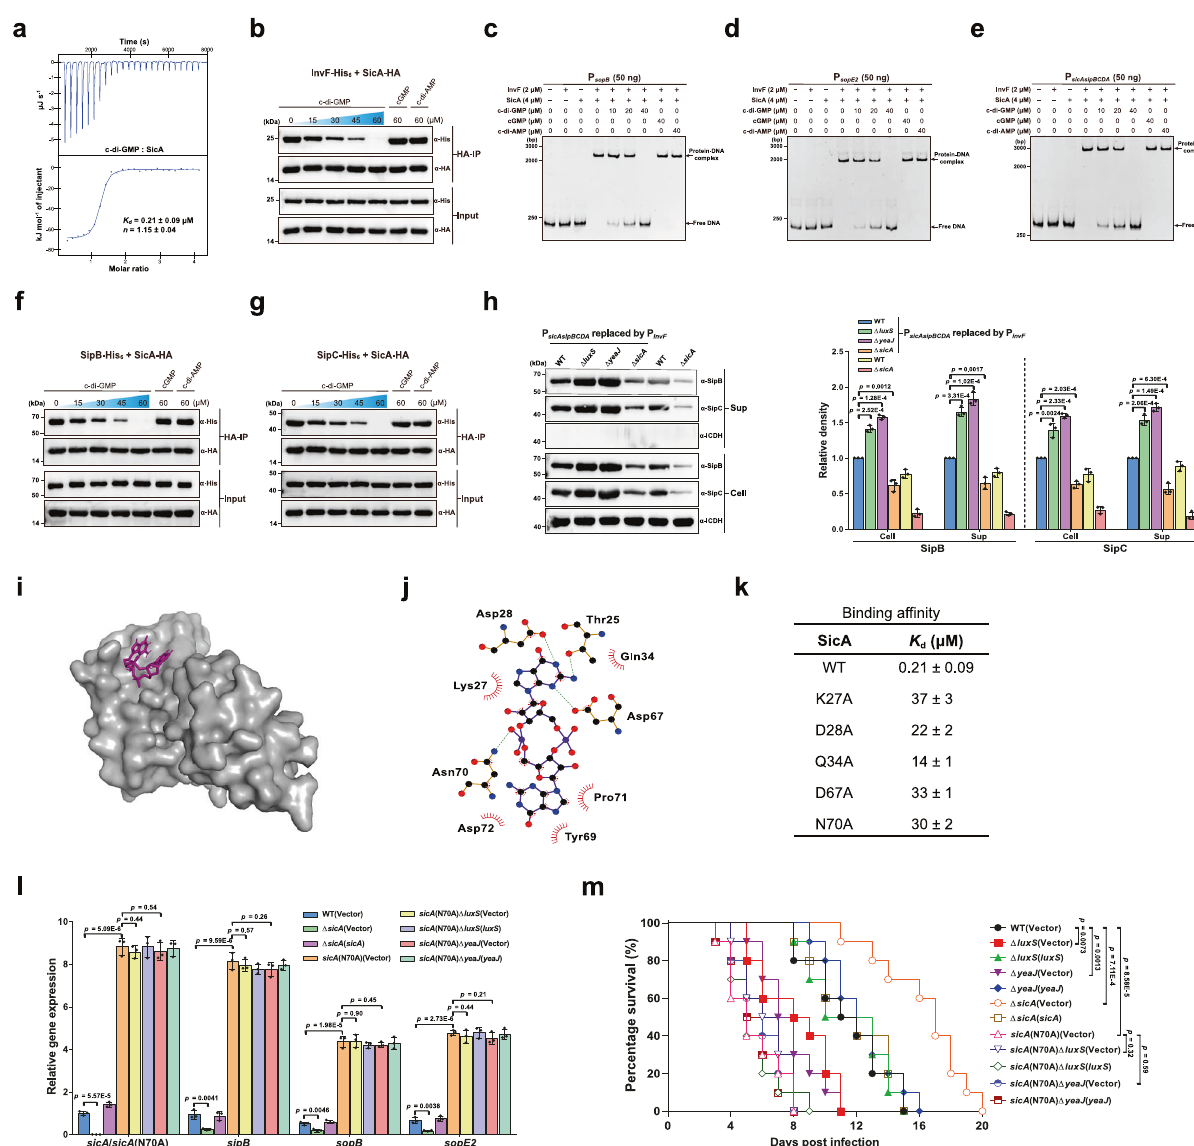
Fig. 5 | Regulation of the expression and secretion of T3SS-1 effectors by c-di- GMPsignalingisdependentonthebindingofc-di-GMPtoSicA.a ITCanalysisof c-di-GMPbinding toSicA.Datashown areonerepresentativeofthreeindependent experiments with similarresults, with K d and complex stoichiometry( n )presented asmean±s.d. b Co-IPofInvF-His 6 withSicA-HAisimpairedbyc-di-GMP,butnotby cGMP or c-di-AMP. The immunoprecipitated proteins (HA-IP) and the total cell lysates (Input) were assessed by western blot analysis. c – e EMSAs for InvF/SicA binding to promoters of sopB ( c ), sopE2 ( d ), and the sicAsipBCDA operon ( e ) in the presenceandabsenceofnucleotides. f , g c-di-GMPdecreasedtheCo-IPofSipB-His 6 ( f ) and SipC-His 6 ( g ) with SicA-HA in a dose-dependent fashion. h Western blot analysisofintracellularaccumulationandsecretionofSipBandSipCbystrainswith P sicAsipBCDA replaced by P invF . Band intensities were presented as values relative to that of the wildtype with promoter replacement (mean±s.d.; n =3 independent experiments). i Surface representation of the homology model of SicA in complex